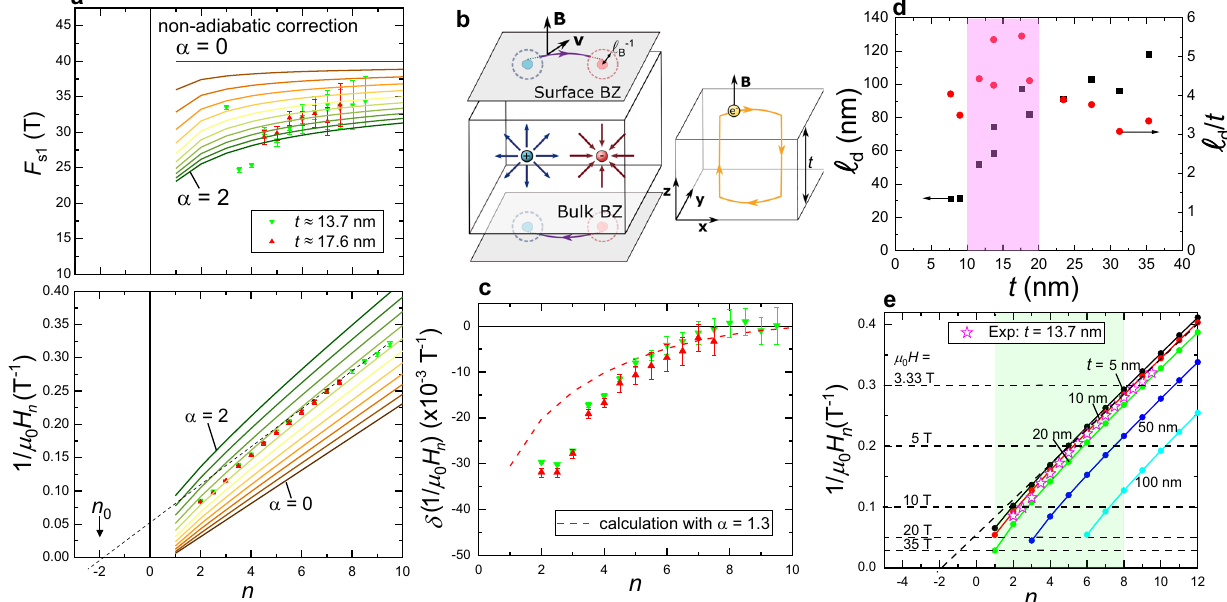
Fig. 6 The comparison to simulated Weyl orbit quantum oscillations. a The simulated curves based on the WOE formula with non-adiabatic correction are plotted and compared to the experimental data from SRO thin fi lms with t ≈ 13.7 and 17.6 nm, where the color codes for the solid lines represent the α parameters ranging from 0 to 2.0 with a step of 0.2. The experimental data are found to fall between the simulated curves with α ≈ 1.2 and 1.4, exhibiting both a downward bending curvature in 1/ μ 0 H n − n curve and an unusually large phase shift n 0 ≈ − 2. b An illustration of the nonlocal cyclotron orbit resulting from WOE. c shows the deviation from linearity δ (1/ μ 0 H n ) as a function of n due to non-adiabatic correction, which is in good agreement with the simulated curve with α = 1.3. The error bars for the experimental data were derived from the standard deviations in the extracted 1/ μ 0 H n values, which were error propagated to give the corresponding uncertainties for F s1 and δ (1/ μ 0 H n ). d The extracted Drude mean free path ( ℓ d ) and the ratio of ℓ d / t as a function of t , showing the largest ℓ d / t for 10 < t < 20 nm. e The simulated 1/ μ 0 H n − n curves for α = 1.3 with different t s based on WOE, inferring an optimum thickness of about t ~ 10 – 20 nm for the dominant WOE in SRO thin fi